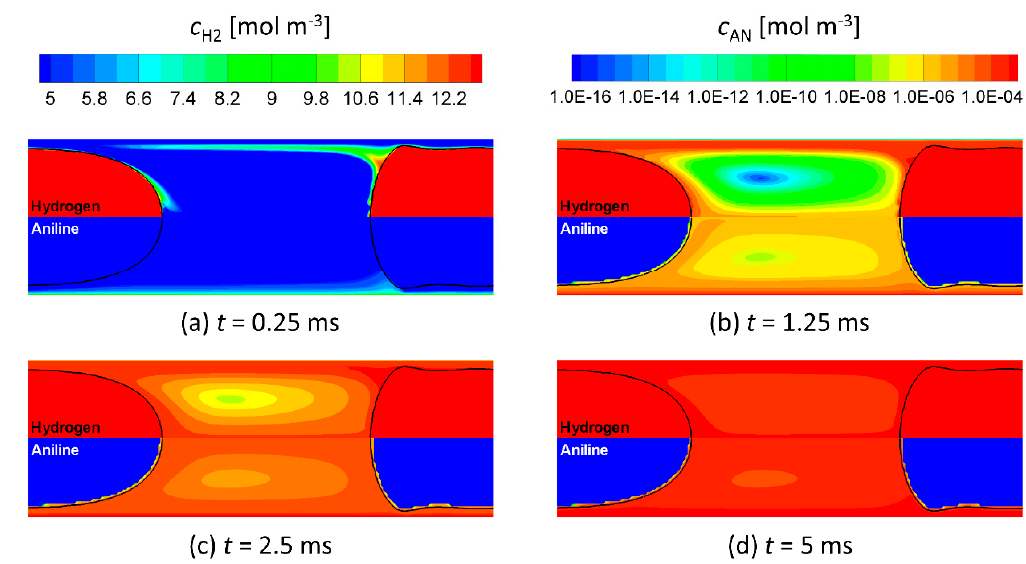
Figure 6. Concentrations field of bulk species hydrogen (top half of each sub-image) and aniline (bottom half) at different times: ( a ) 0.25 ms, ( b ) 1.25 ms, ( c ) 2.5 ms and ( d ) 5 ms.